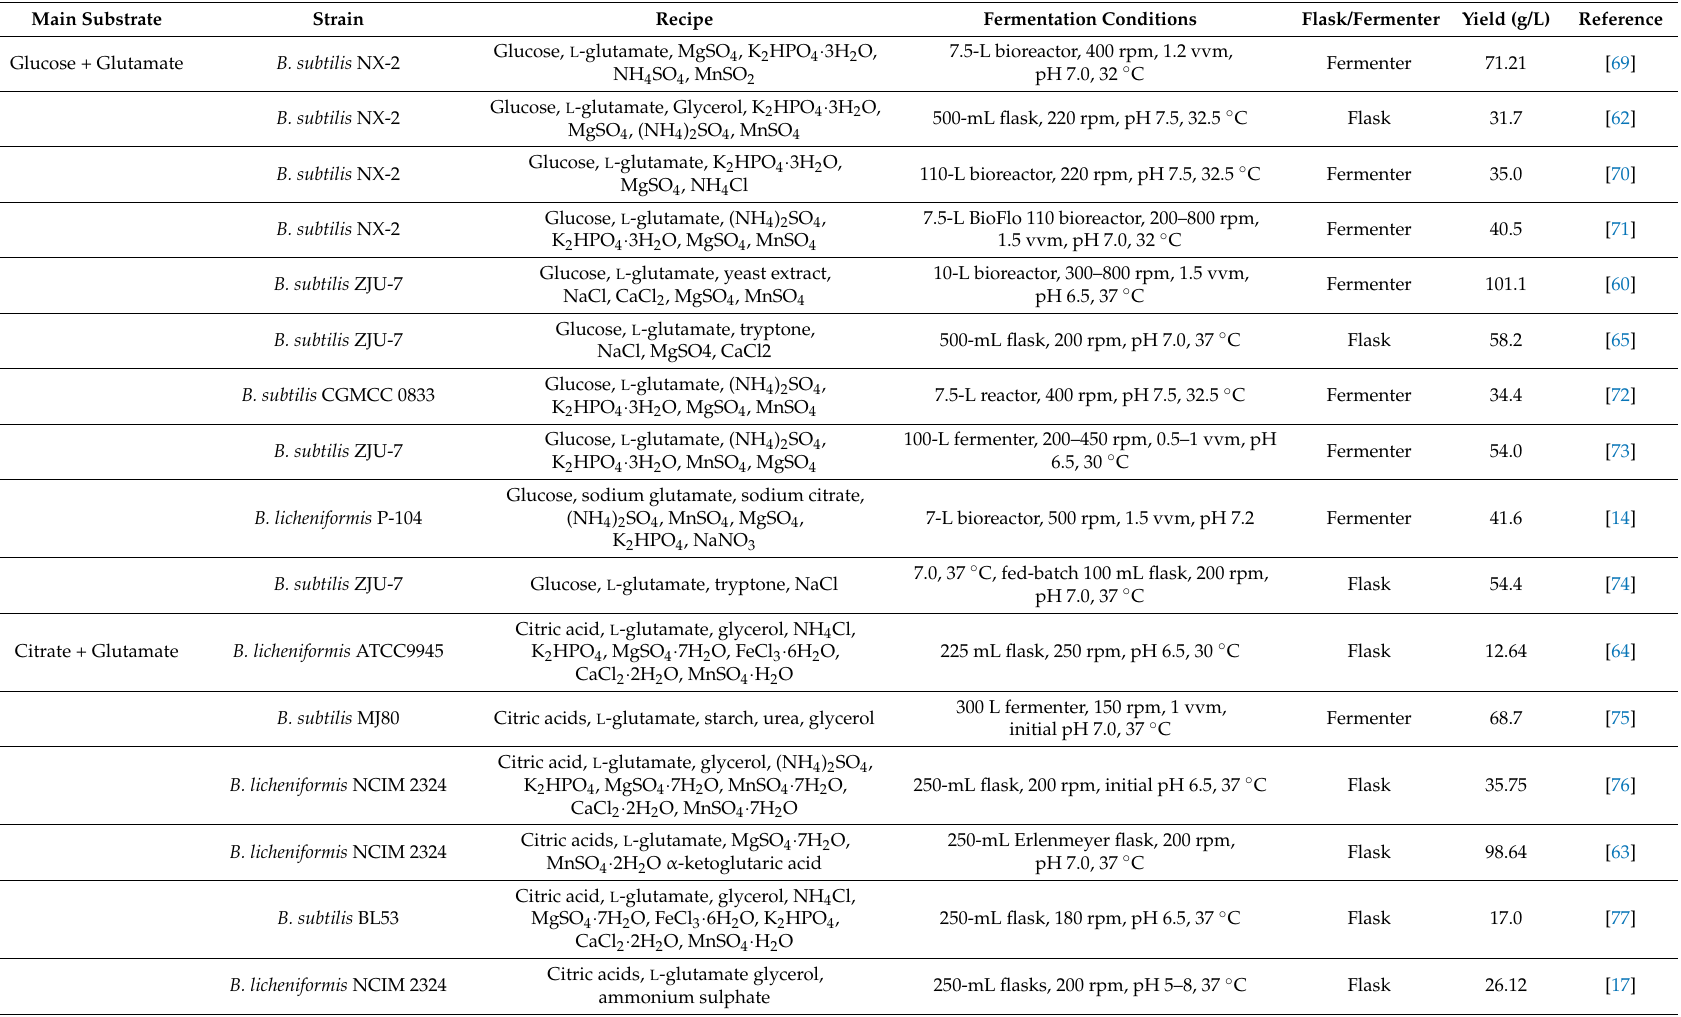
Table 3. γ -GPA fermentation strains, fermentation recipe, process control, and